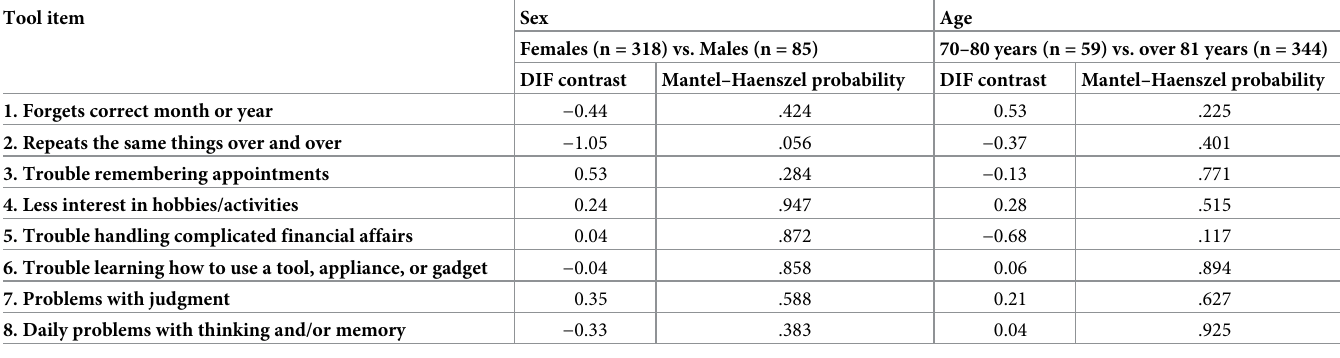
Table 3. Results of the differential item functioning analyses. Tool